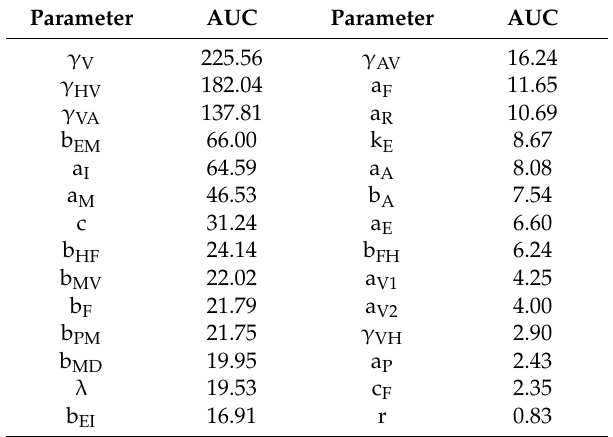
Table 3. AUC of virus equation for each parameter in Hancioglu model.